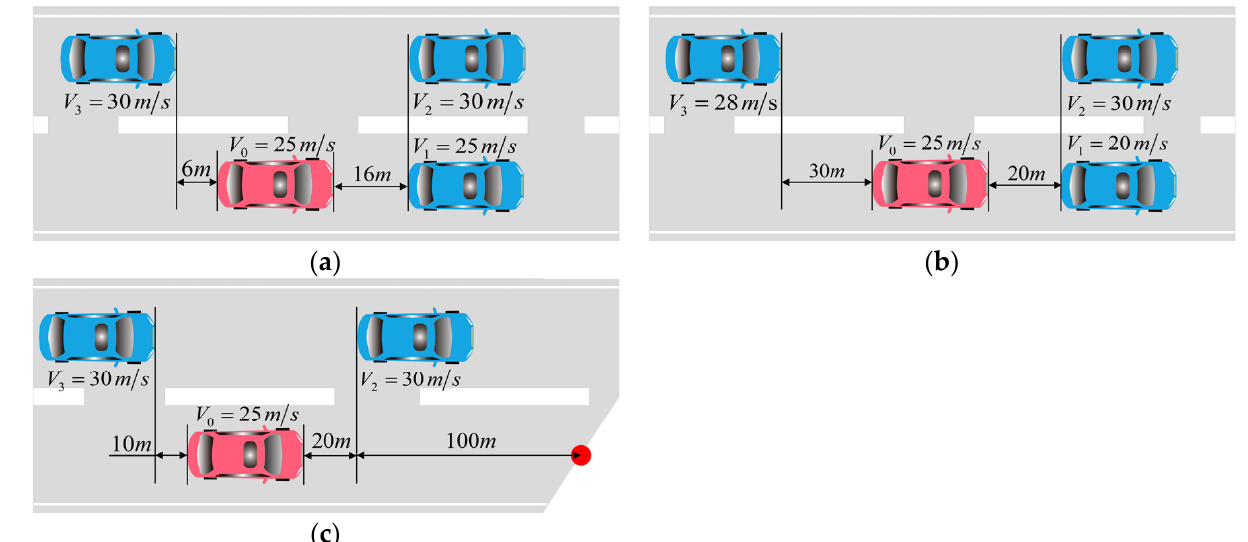
Figure 12. HIL traffic environment settings. ( a ) Traffic environment Case Ⅰ . ( b ) Traffic environment Case Ⅱ . ( c ) Traffic environment Case Ⅲ.